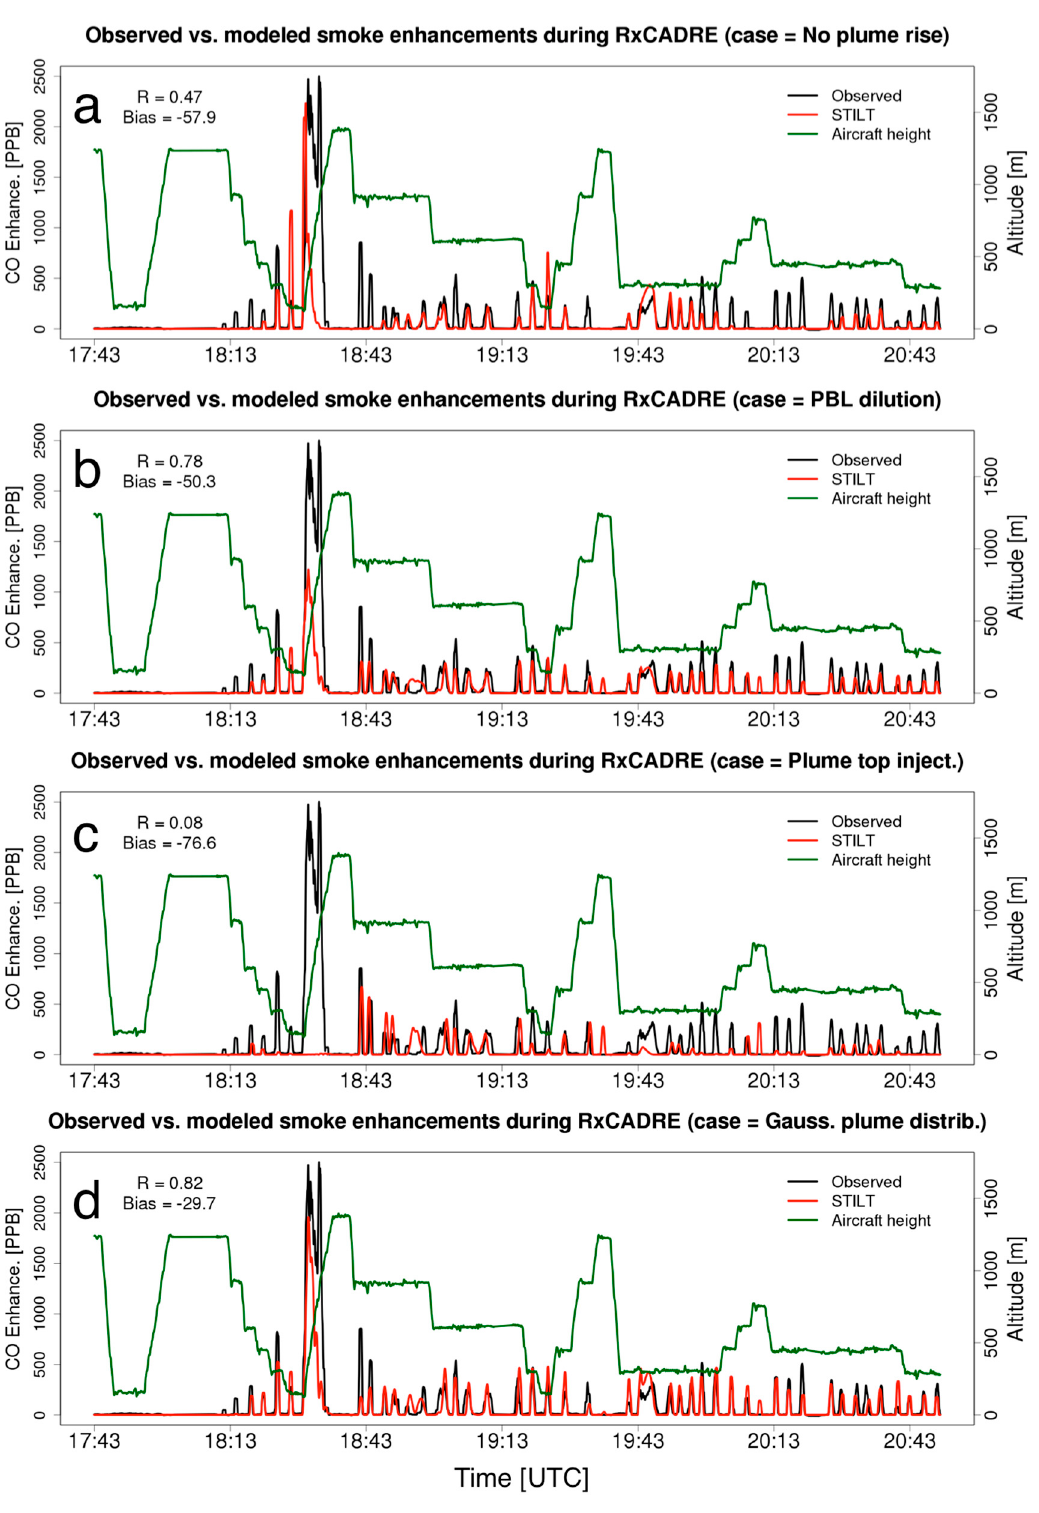
Figure 8. Modeled vs. observed CO enhancements during the L2F prescribed burn. Similar to Figure 9, the background CO concentrations (~110 ppb) were subtracted from the observed concentrations. Both modeled and observed CO enhancements were smoothed using a 20-s centered running average. ( a ) No plume rise, ( b ) PBL dilution, ( c ) plume-top, and ( d ) Gaussian plume rise configurations.